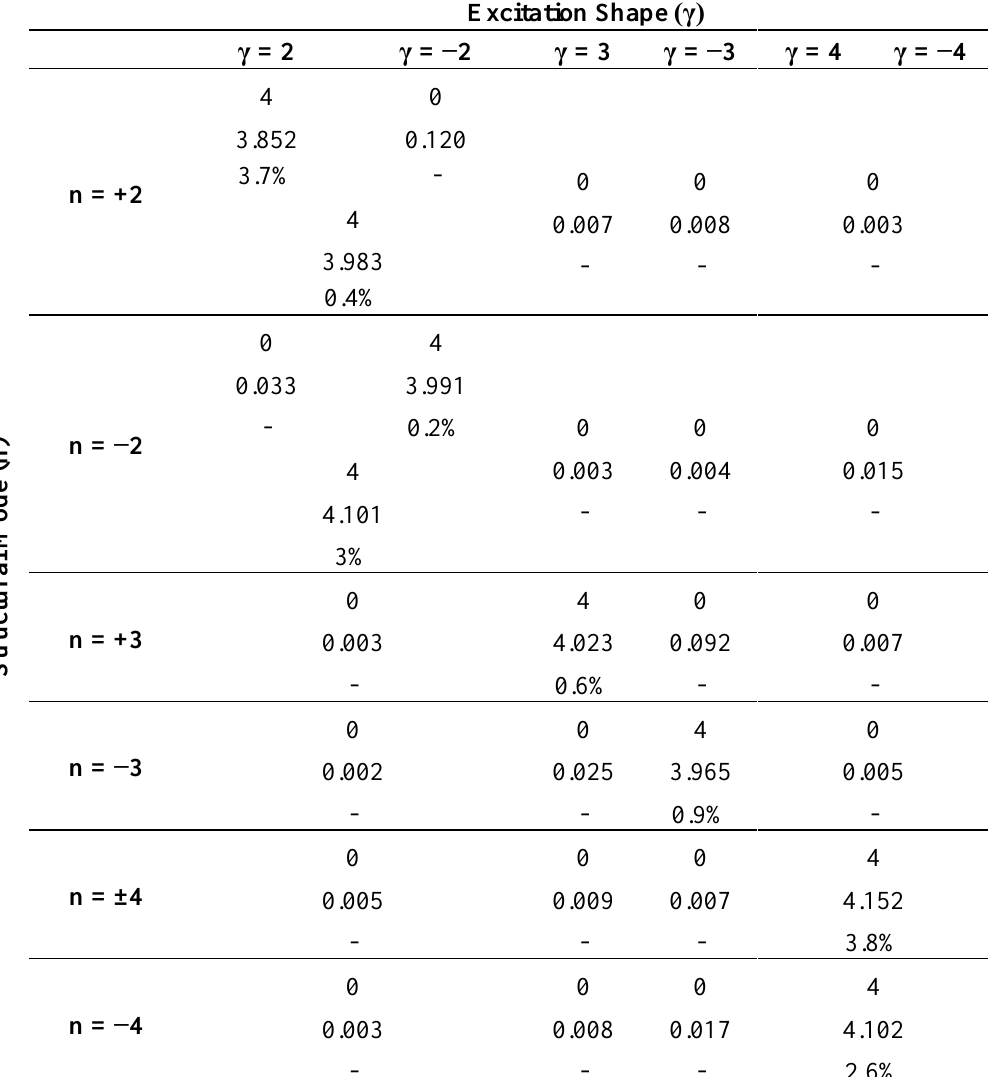
Table 4. Amplification of the resonances (A ( = 8 Hz) due to the different excitation patterns. Analytical, experimental and disk